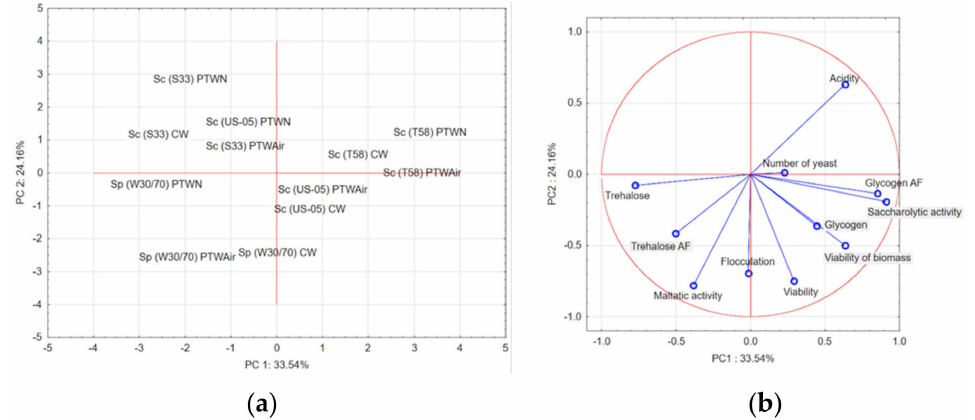
Figure 1. ( a ) Principal component analysis—plot of component weights. ( b ) Principal component analysis showing the qualitative characteristics of the Saccharomyces cerevisiae (SafBrew T58, US-05, S33) and Saccharomyces pastorianus (SafLager W30/70) yeast strain after rehydration with plasma- treated